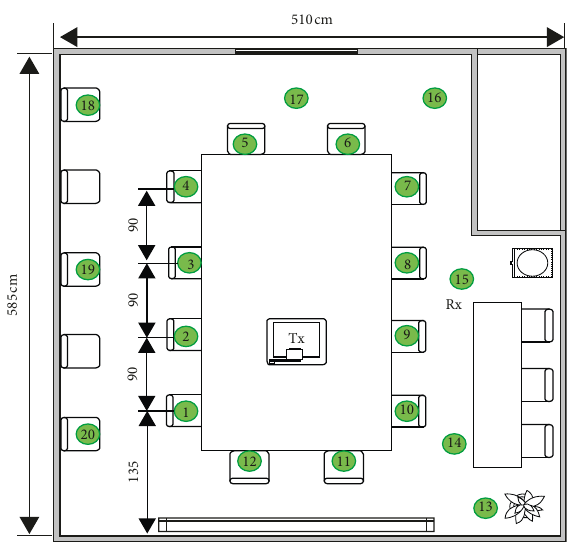
Figure 3: Measurement scenario. Table 3: Antenna parameters.